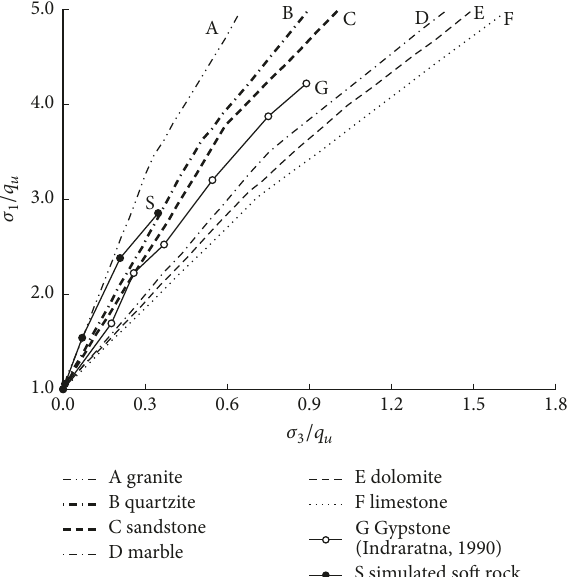
Figure 8: Hoek-Brown failure representation of simulated soft rock and various rocks (data from [2,